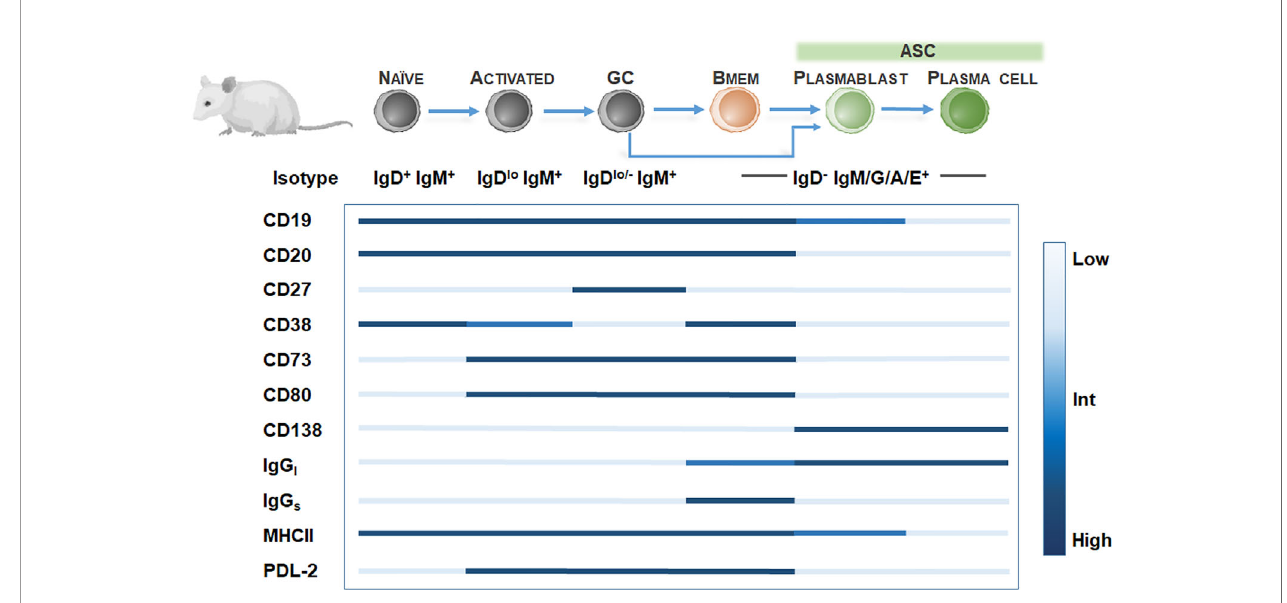
FIGURE 2 | Bmem phenotyping markers in murine models. Overview of B cell differentiation in mice, focusing on naïve B cell to ASC phenotypes, with BCR isotype and surface marker expression. Surface marker levels simpli fi ed to highlight relative expression, including low, intermediate, or high